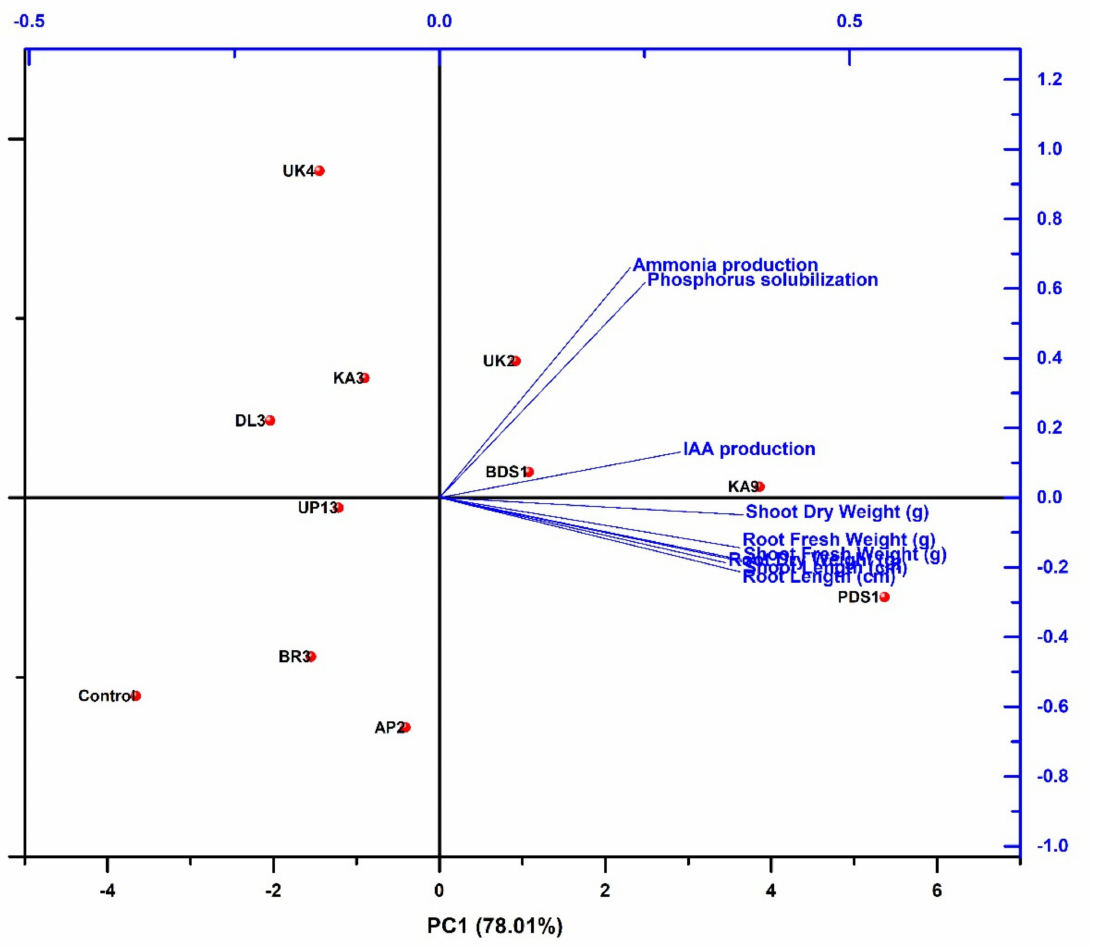
Figure 8. Principal component analysis depicting correlation and significance among plant growth promoting activities, growth parameters of chilli and rhizobacterial